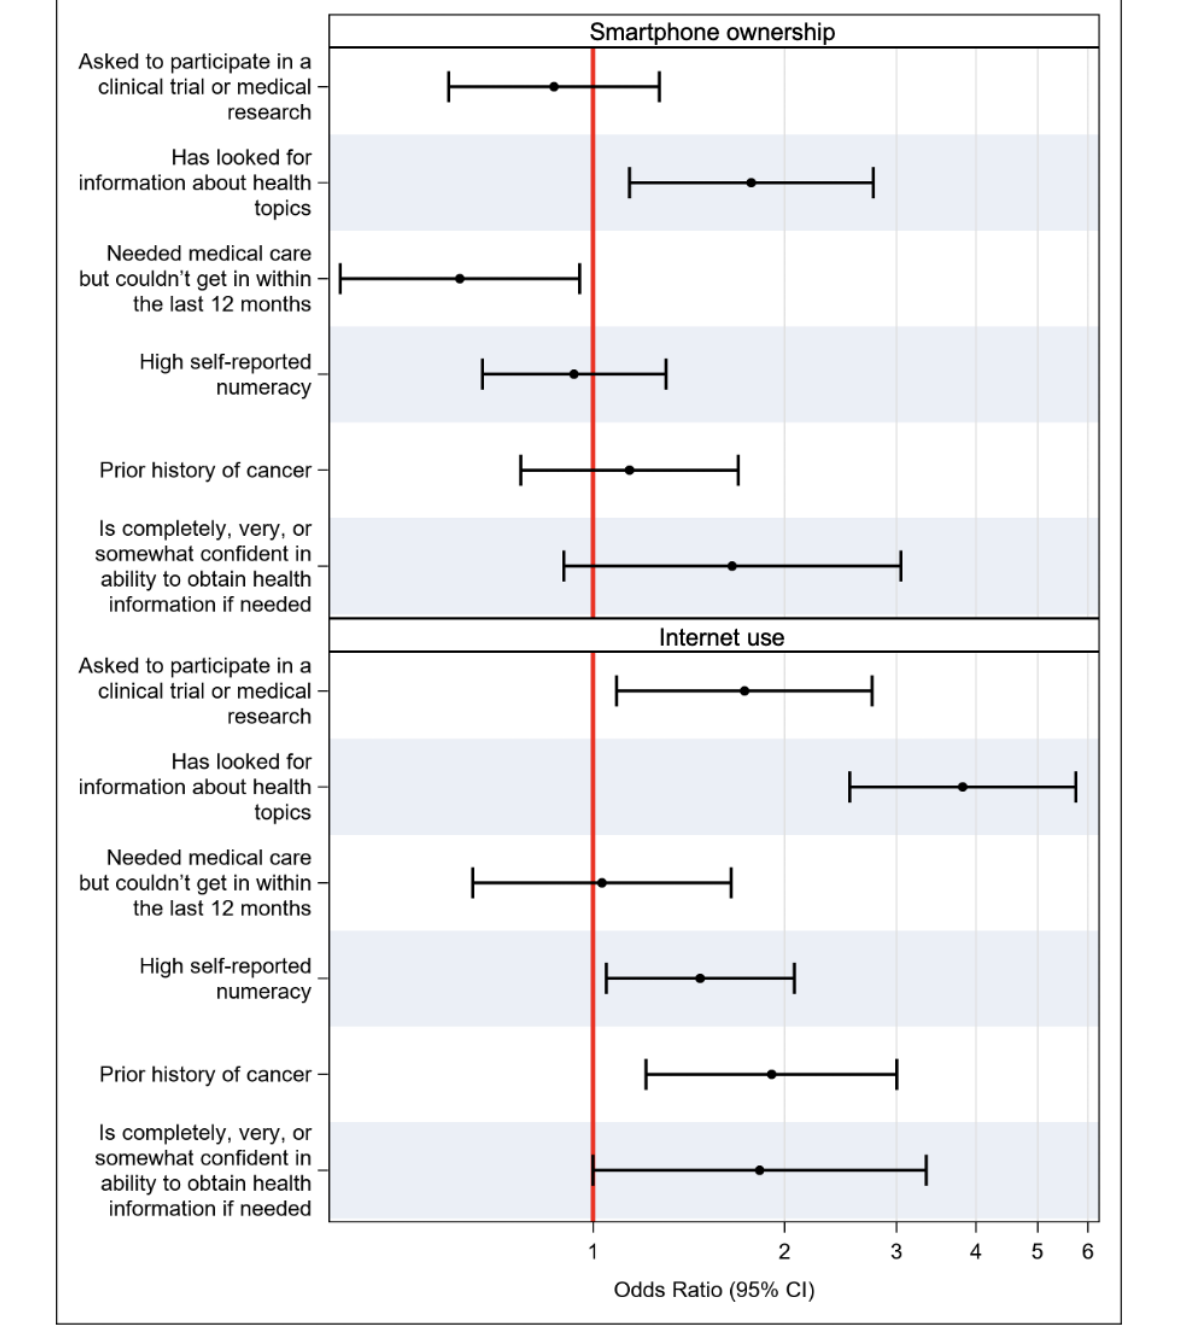
Figure 2. Association of markers of health literacy and health access with smartphone ownership (top) and internet use (bottom). Separate models were used for each outcome listed on the left, with smartphone ownership or internet use included as a